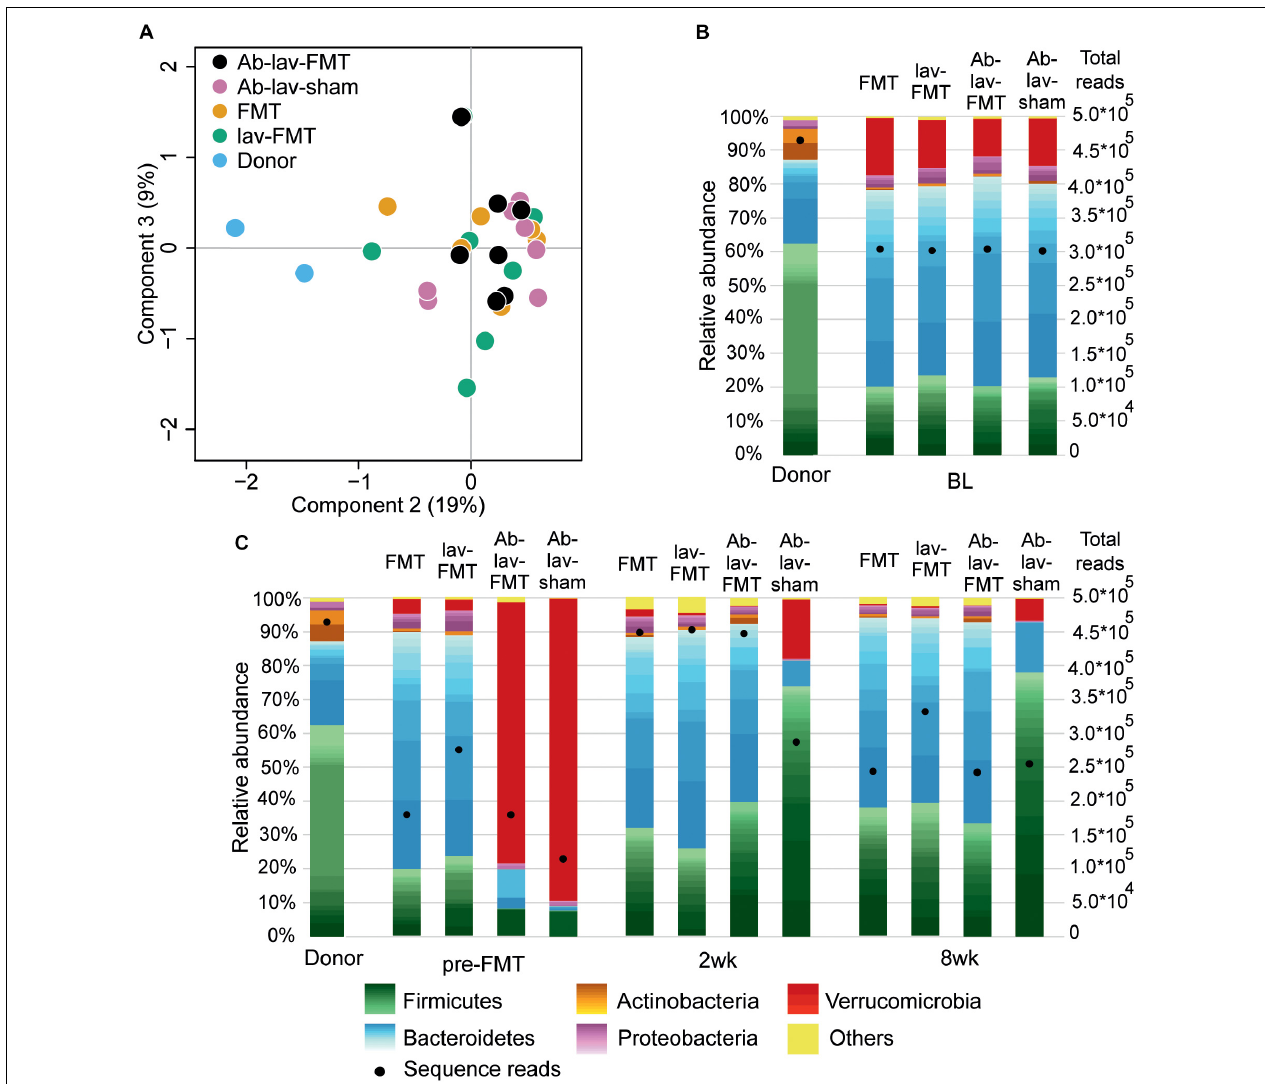
FIGURE 2 | (A) PCoA of microbiota profiles at bacterial genus level from the study groups at baseline. (B) Fecal microbiota composition in donor and recipient mice at baseline. Relative abundance scaled to 100%, and number of sequence reads marked with bullets. Within phyla, individual genera are shown with different shades, and the lightest color shows the combined abundance of the least abundant genera ( < 0.5% of total). (C) Microbiota composition of donor and recipient mice at other time points in the